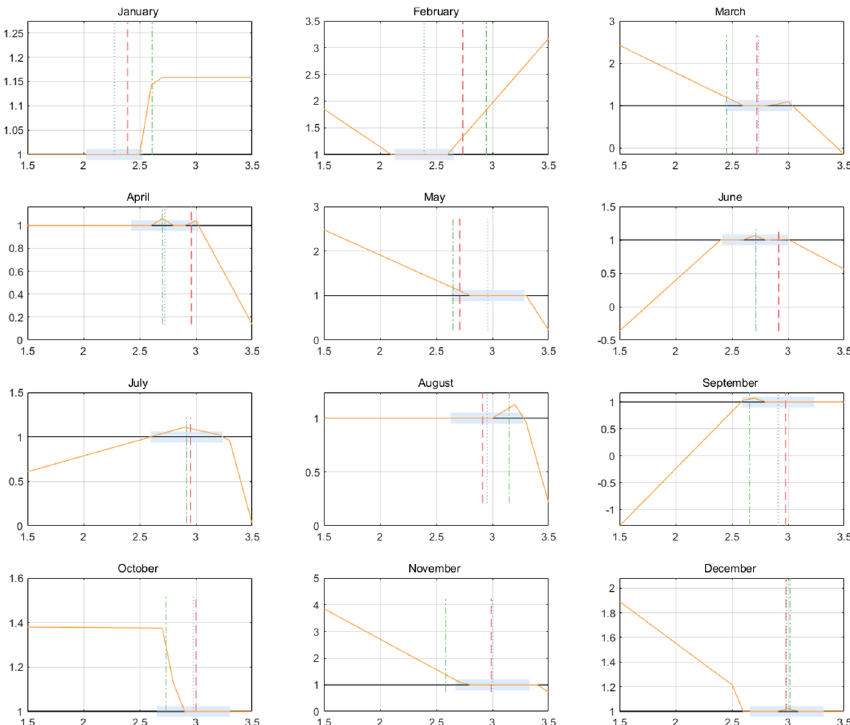
Fig. 7 12-month risk-free model terminal wealth. Note: The X-axis of charts is the forward price of the underlying assets, and the Y-axis is the expected wealth in the next period. The red line is the real forward price of the underlying asset. The green line is the predicted forward asset price. The x-axis covered by the blue block means the risk-free